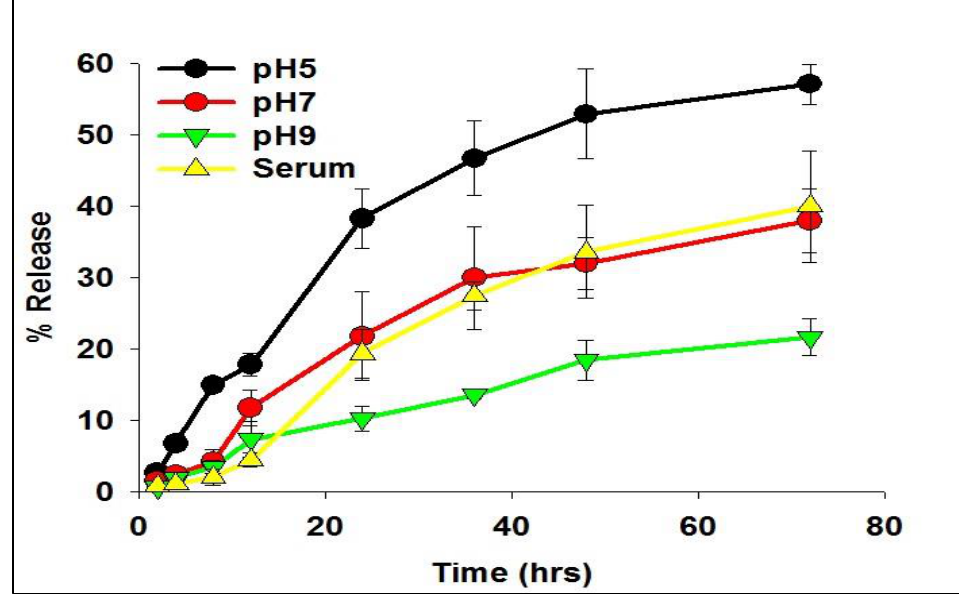
Figure 2. Time course of siRNA release from subtilosomes for extended period. The siRNA-loaded subtilosomes were incubated in sterile 20-millimolar phosphate-buffered saline of various pH (pH 5, 7, and 9) for an extended period. The co-incubation of siRNA-loaded subtilosome with serum components showed release kinetics of the encapsulated siRNA, similar to that of plain (no serum components) subtilosome. The released siRNA in the surrounding medium was quantified over time by HPLC, as described in the Materials and Methods section. Each time point represents the mean of triplicate readings ± standard deviation.